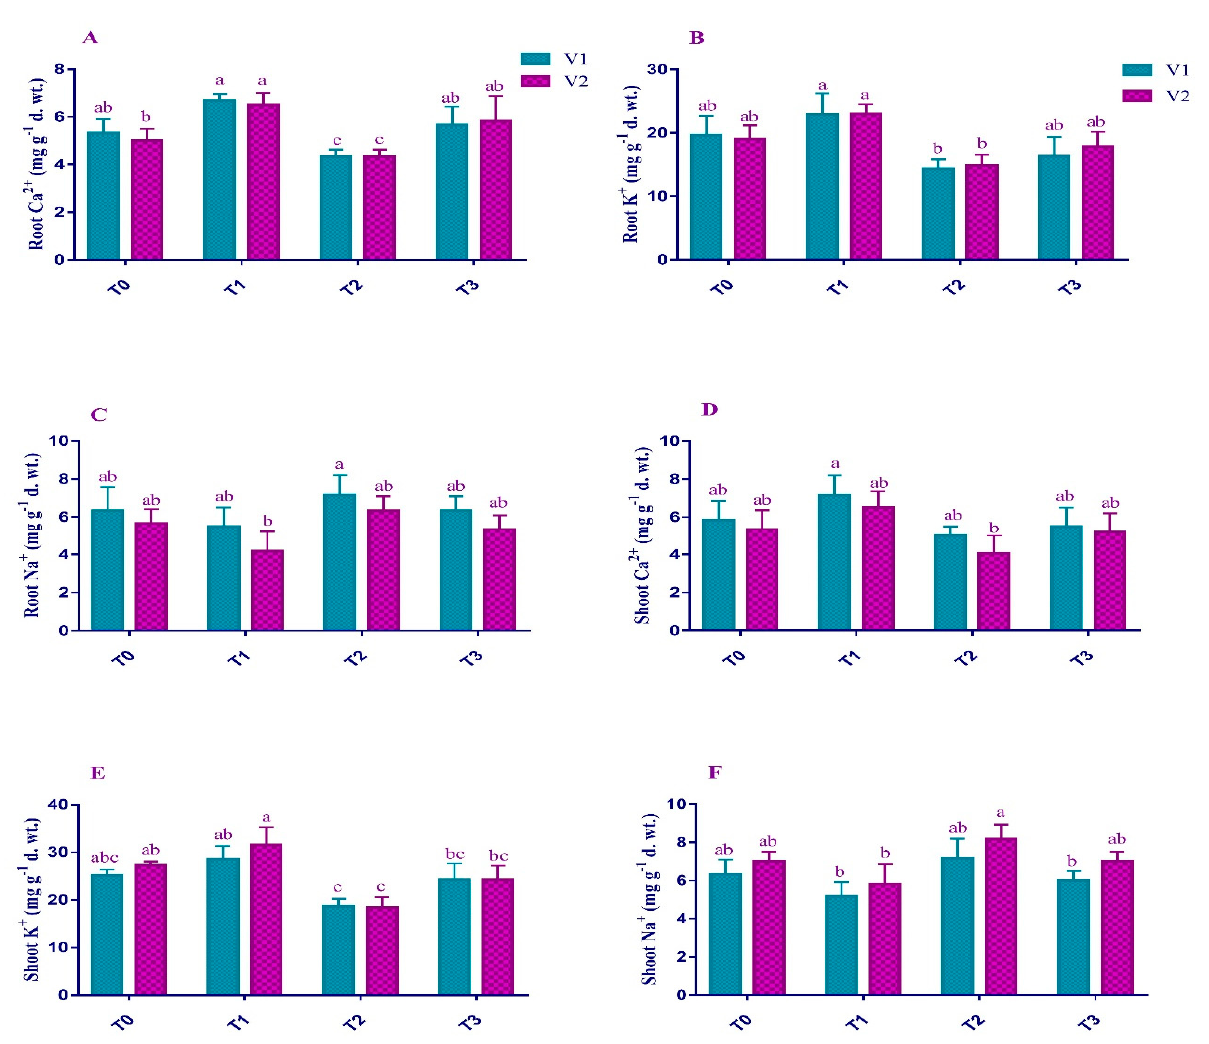
Figure 5. Effect of Pb and EDTA on ( A ) root calcium (mg g − 1 d. wt.), ( B ) root potassium (mg g − 1 d.